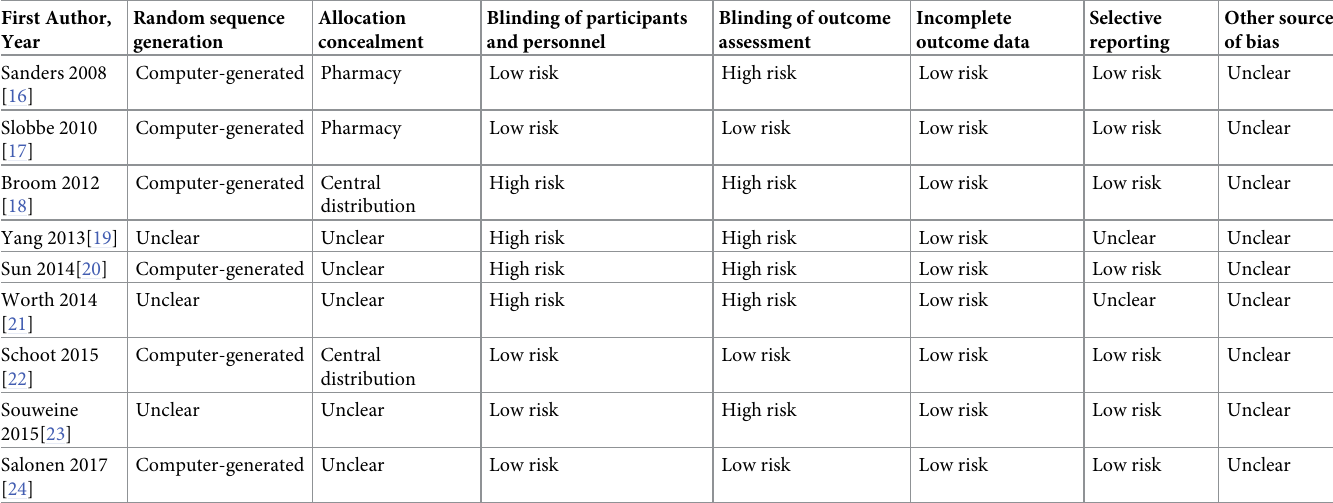
Table 3. Methodological quality of the included studies.